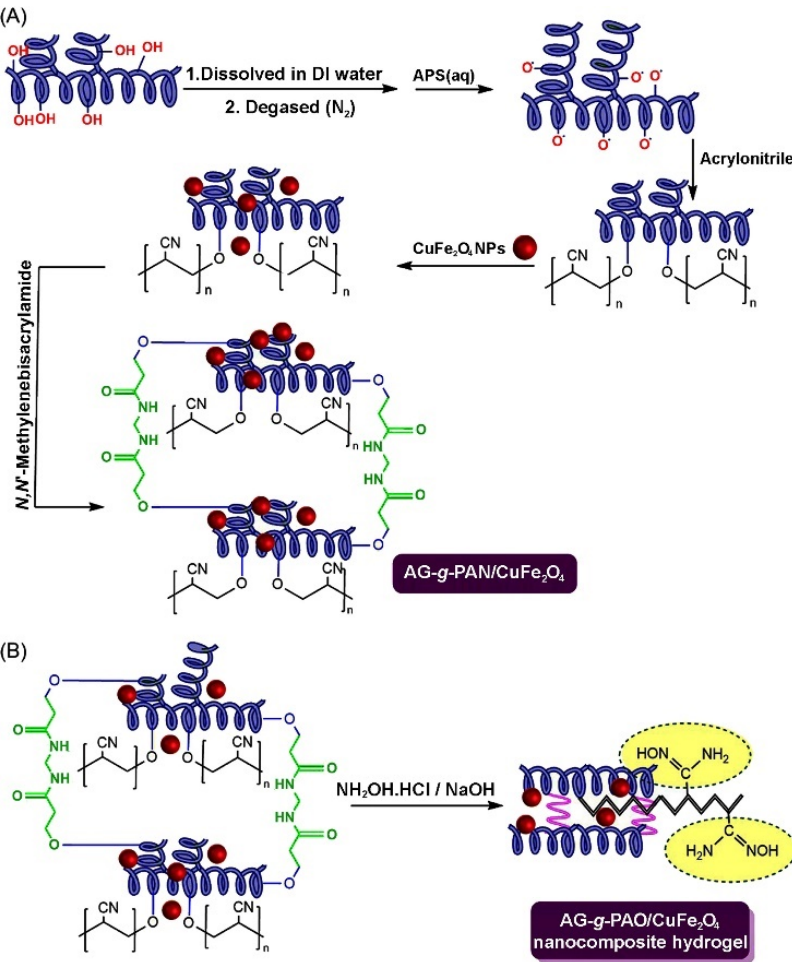
Figure 11. The grafting polymerization reaction process of polyacrylonitrile onto arabic gum and amidoximation reaction [217].